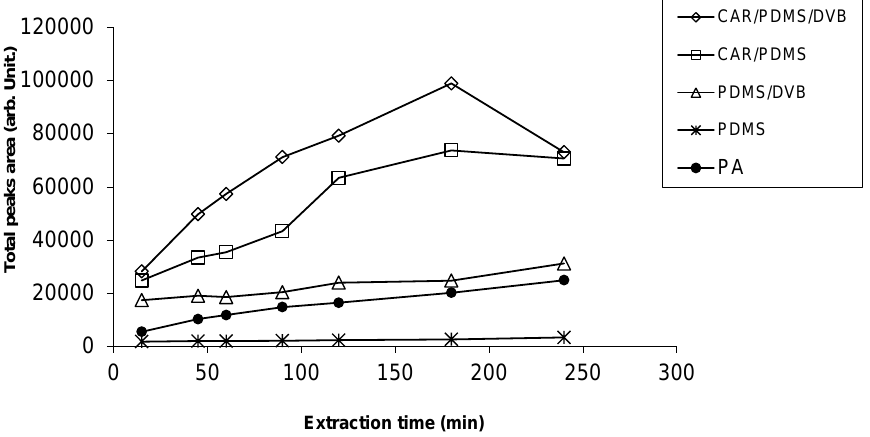
Figure 1. Total VOCs peak area (arbitrary unit; area/10 5 ) for CAR/PDMS/DVB, CAR/PDMS, PDMS/DVB, PDMS and PA fibers at different extraction times (15, 45, 60, 90, 120, 180, 240